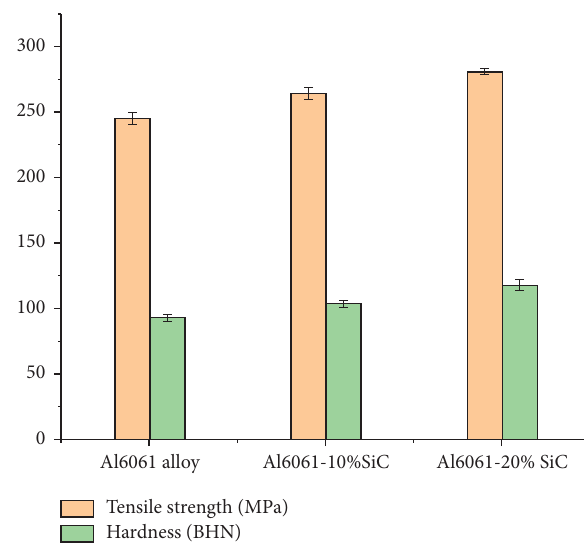
Figure 5: Comparison of mechanical properties of three